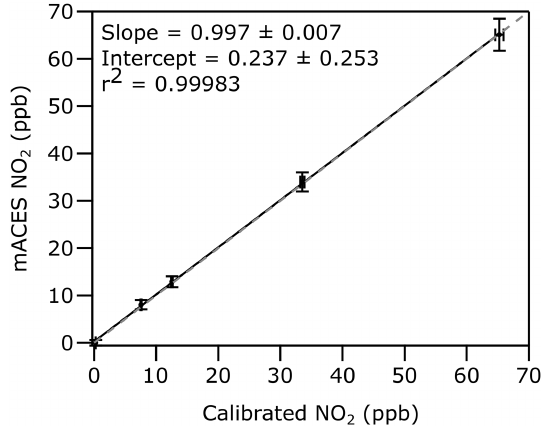
Figure 2. Correlation plot showing mACES measurements of NO 2 standards generated by quantitative reaction of known amounts of O 3 with NO. The grey dashed line shows the 1 : 1